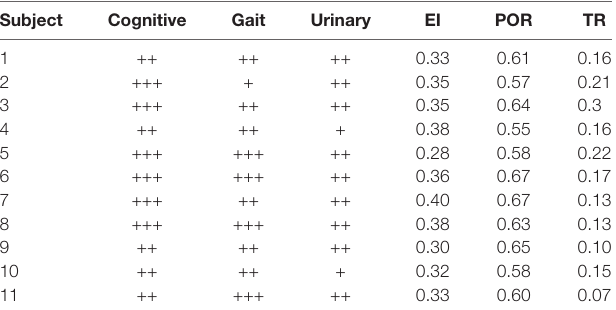
TABLE 4 | Patients’ clinical evaluation and radiological indexes of a sample of 11 out 3,193